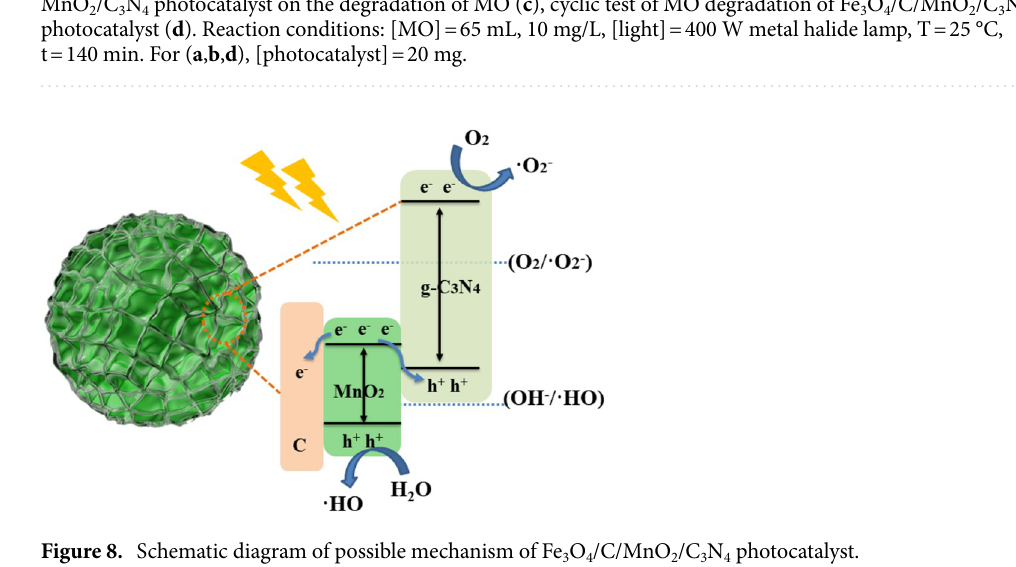
Figure 8. Schematic diagram of possible mechanism of Fe 3 O 4 /C/MnO 2 /C 3 N 4